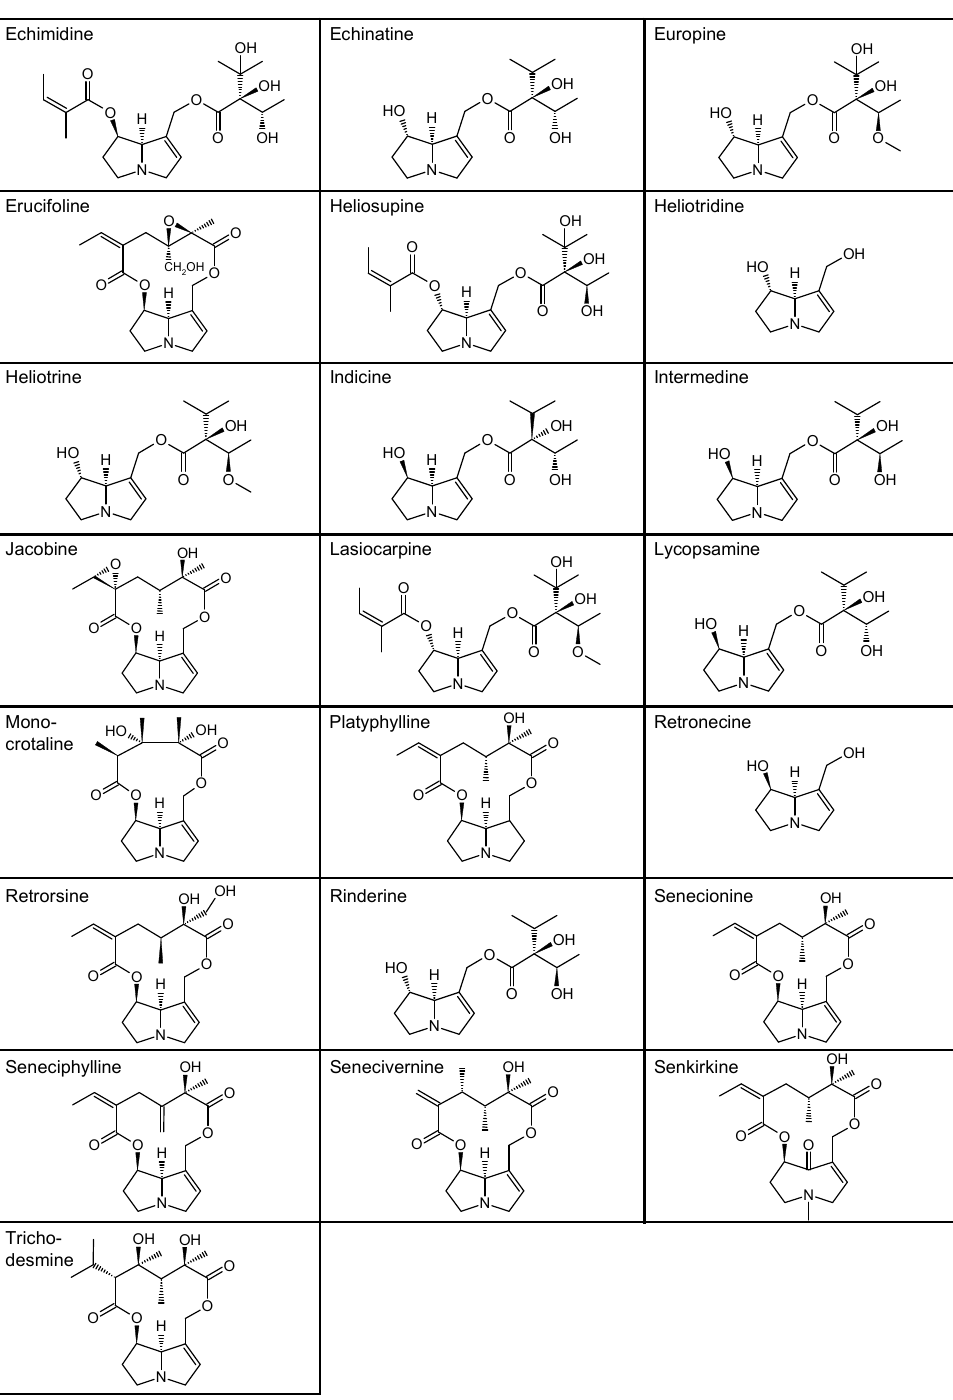
Figure 1. Structures of the 22 pyrrolizidine alkaloids used in this study.